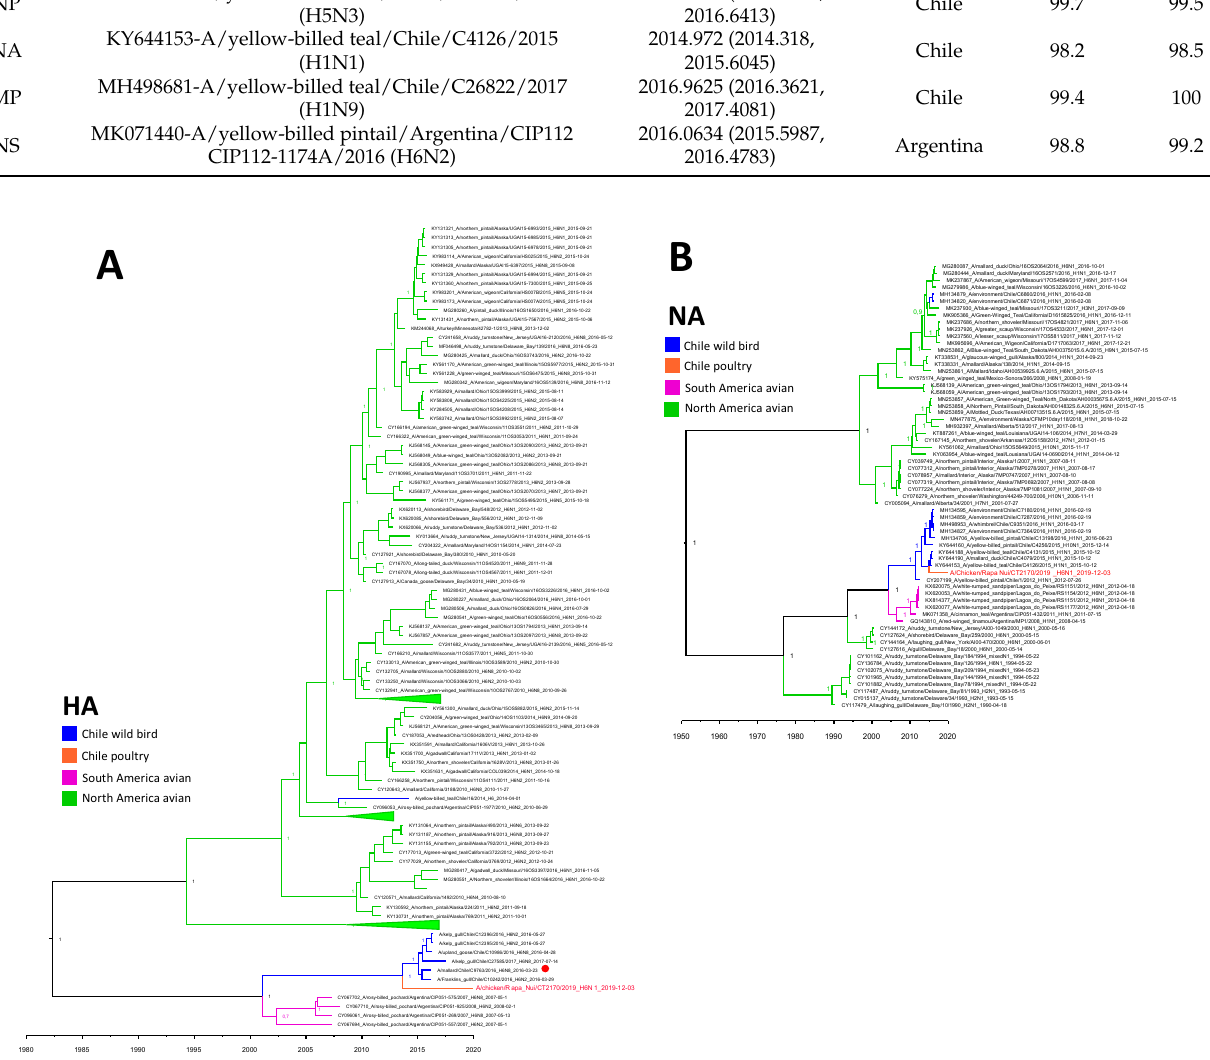
Figure 1. Bayesian MMC trees of the H6 ( A ) and N1 ( B ) genes. Time stamped trees that show temporal and phylogenetic relationships between the virus obtained in Rapa Nui (tip text in red) to Chilean, South American, and North American AIV’s. Node labels indicate the posterior probability of the node. Red circle in panel ( A ) indicates strain used for hemagglutination inhibition test. Collapsed nodes indicated with triangles.